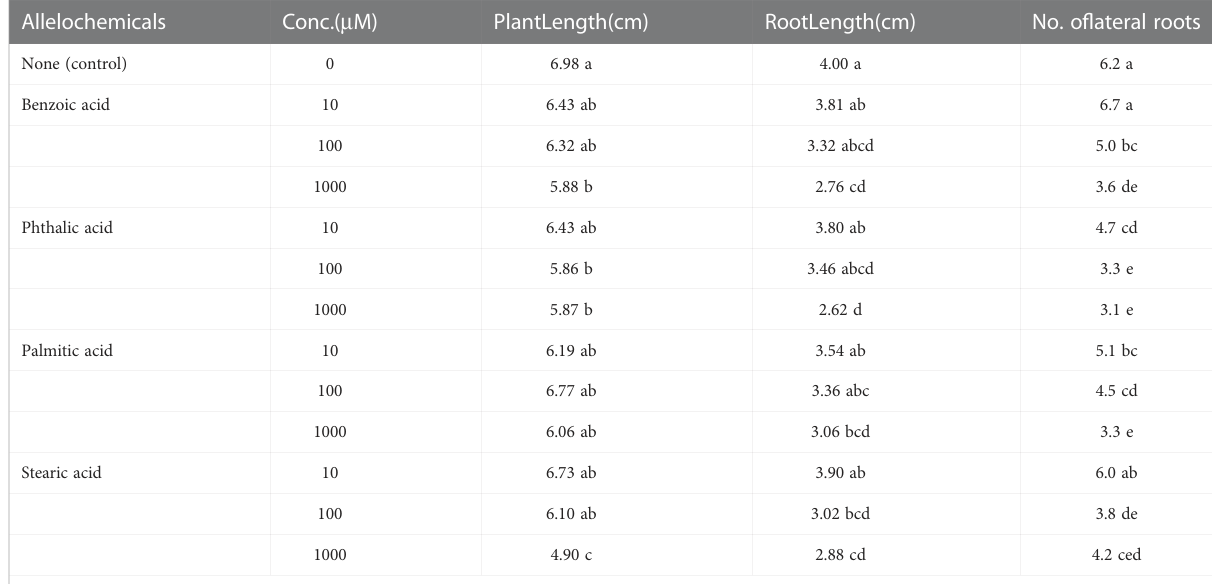
TABLE 4 Effects of the identi fi ed chemicals at different concentrations on the growth of P. notoginseng.